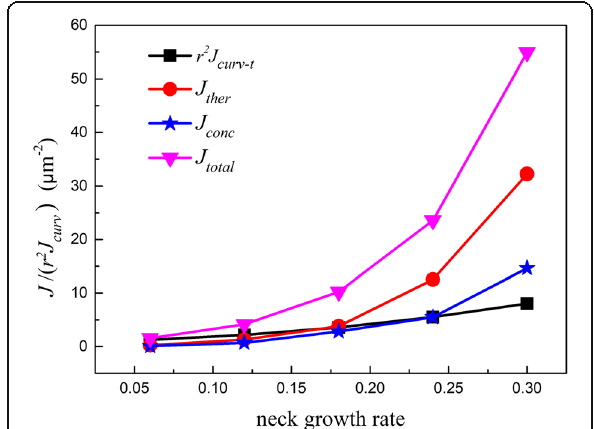
Fig. 7 Comparison of the ratio of diffusion flux under simultaneous diffusion